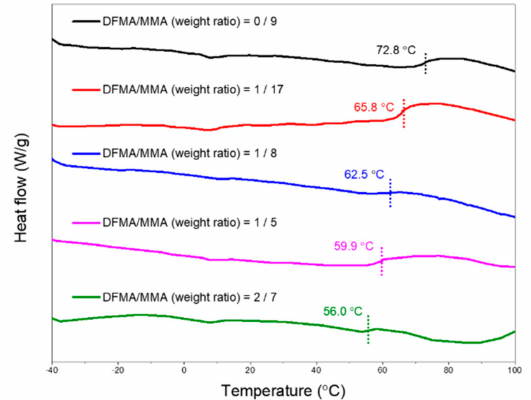
Figure 3. Differential scanning calorimetry (DSC) analysis of the as-prepared nanohybrid silica polyacrylate materials prepared by different dodecafluoroheptyl methacrylate (DFMA)/methyl methacrylate (MMA) weight